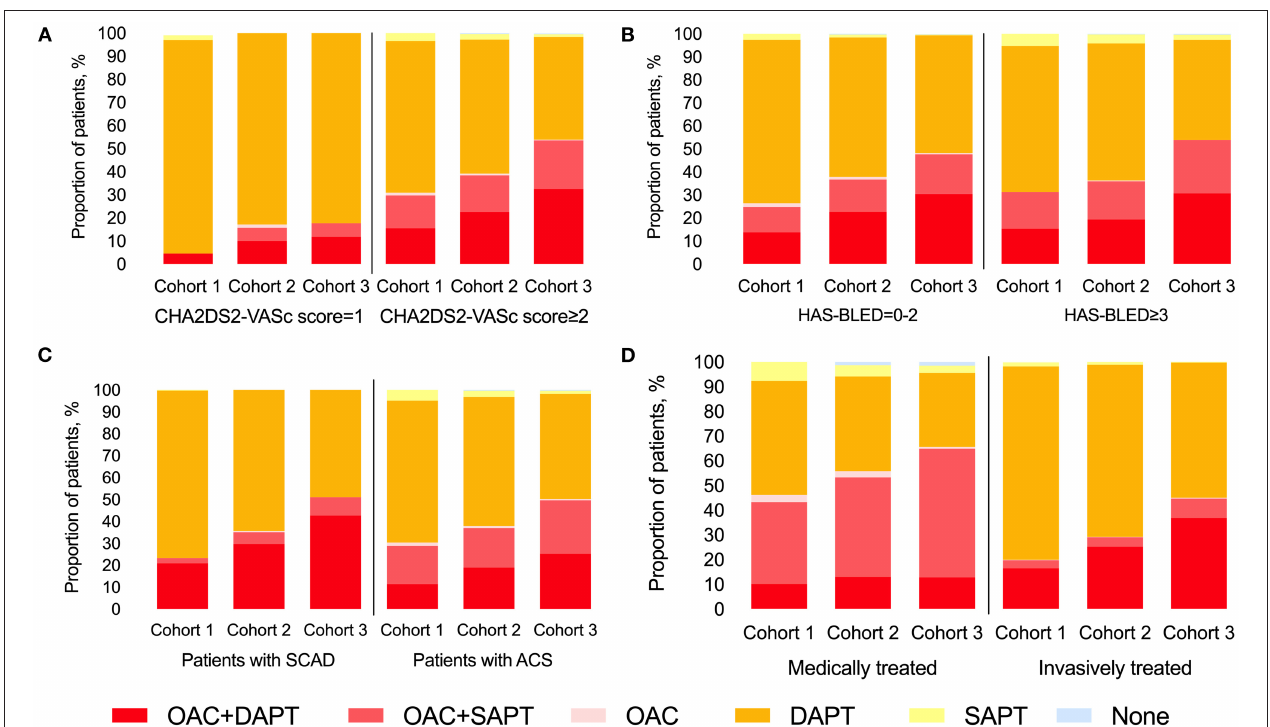
FIGURE 2 | Trend of antithrombotic treatment at discharge stratified by CHA2DS2-VASc score and cohort (A) , by HAS-BLED score and cohort (B) , by CAD type and cohort (C) , and by treatment type and cohort (D) . CAD, coronary artery disease; SCAD, stable coronary artery disease; ACS, acute coronary syndrome; OAC, oral anti-coagulants; DAPT, dual antiplatelet therapy; SAPT, single antiplatelet therapy.